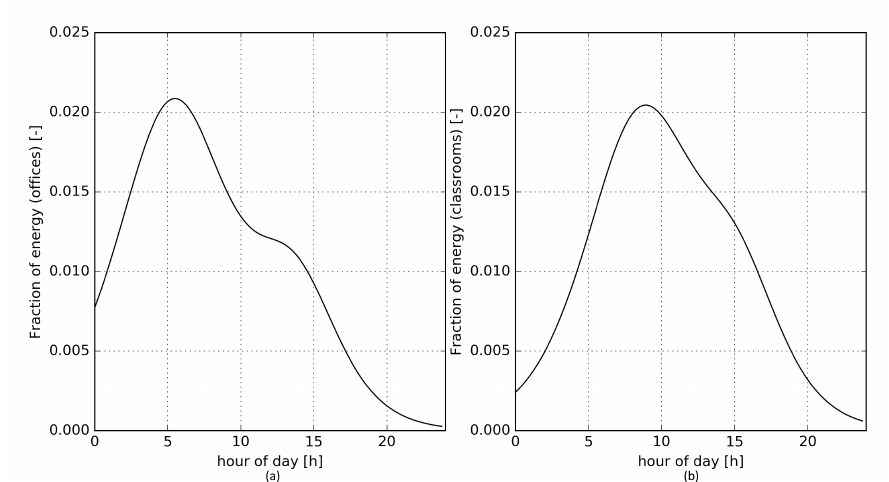
Figure 3. Typical heat consumption profile for a building composed of classrooms ( a ) and another dedicated to offices ( b ). The considered time step is half a